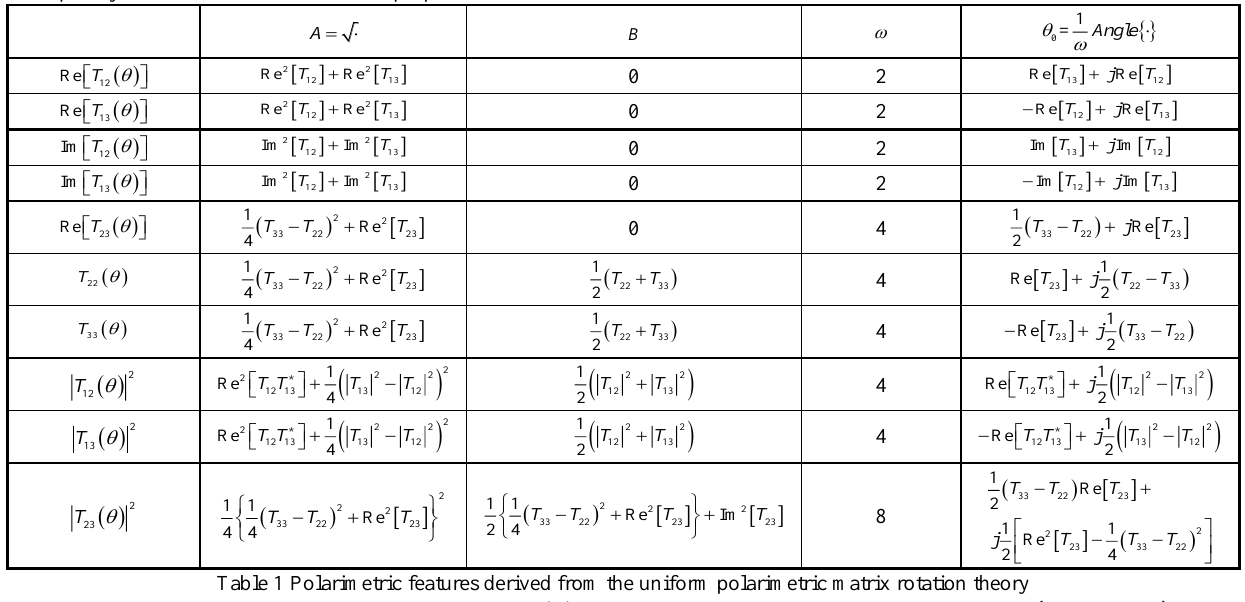
Table 1 Polarimetric features derived from the uniform polarimetric matrix rotation theory where the superscript * denotes the conjugate,  A n g l e a